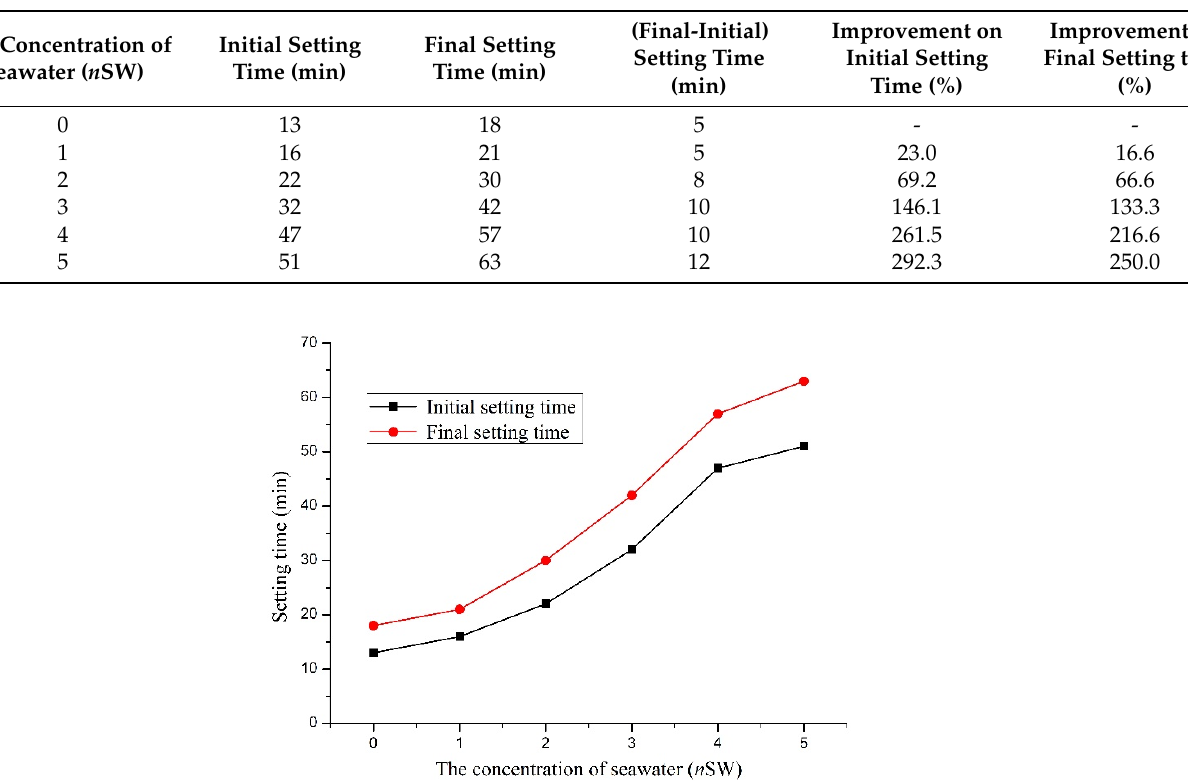
Table 4. The influence of the seawater concentration on the setting time of CSA cement.